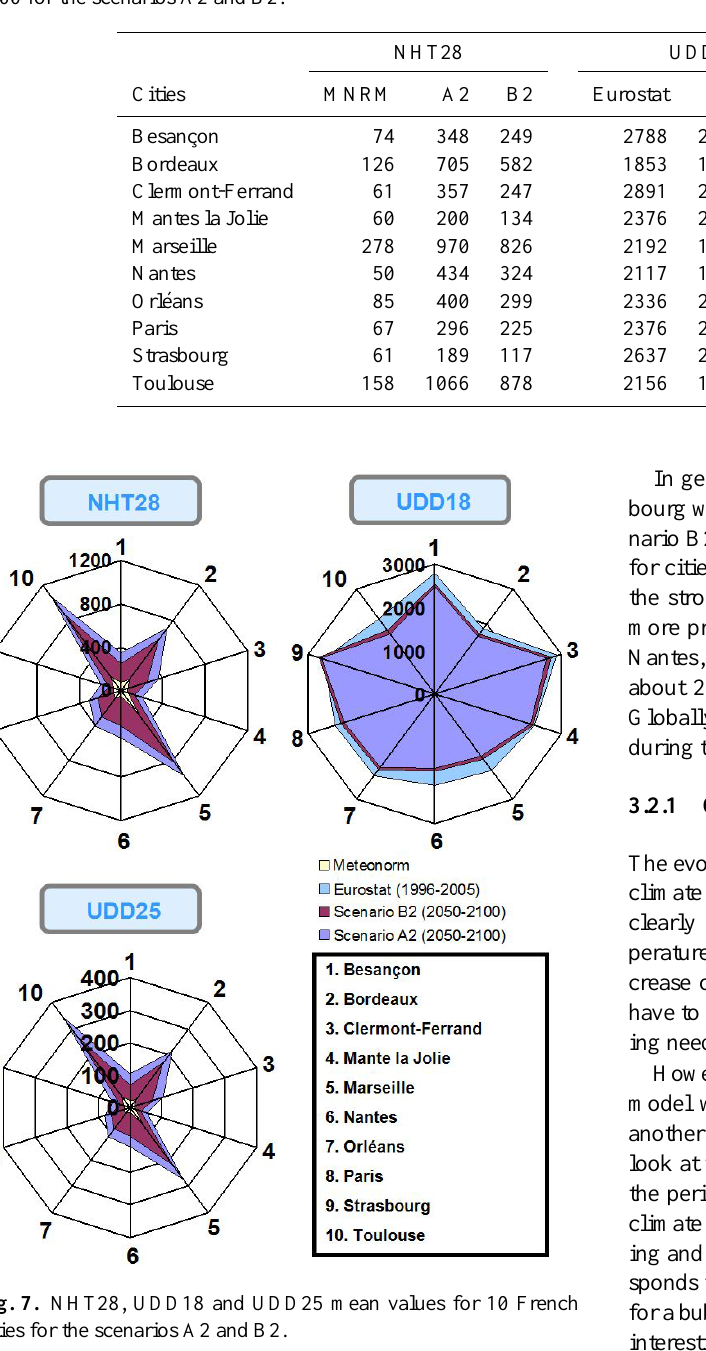
Table 1. NHT28, UDD18 and UDD25 averaged values for 10 French cities for observational data and climate data from the period 2050– 2100 for the scenarios A2 and B2.